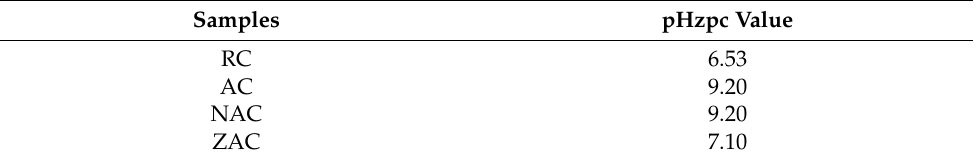
Table 7. The pHzpc value for all types of cassava stem